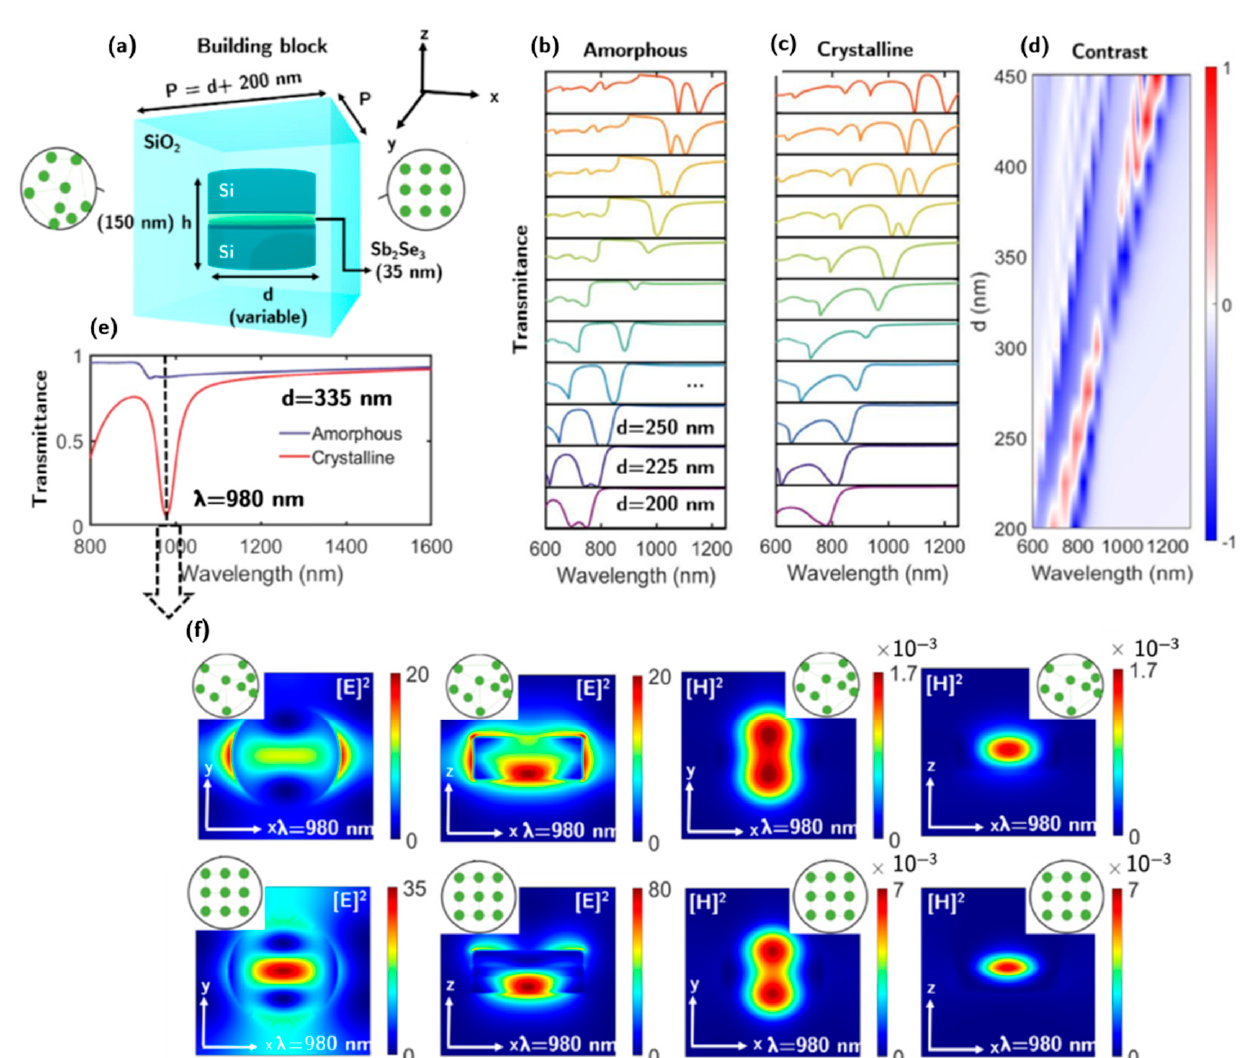
Figure 4. ( a ) The building block of the proposed reconfigurable metasurface. It consists of a sandwich-shaped Si–Sb 2 Se 3 –Si disk embedded in a SiO 2 medium. ( b , c ) Transmittance spectra of the metasurface for the Sb 2 Se 3 amorphous and crystalline phases, respectively, for disk diameters ranging from 200 to 450 nm. ( d ) Contrast in transmission ( ∆ T) between the crystalline and amorphous phases. ( e ) Transmission spectra for amorphous and crystalline phases for a diameter of 335 nm (i.e., an aspect ratio of h/d = 0.45). The dashed line at 980 nm indicates the transition between the zero-backward (amorphous) and the resonance due to the contributions of ED, MD, and AP (crystalline). ( f ) Square modulus of electric and magnetic fields in the near-field regime for different planes and both Sb 2 Se 3 phases at λ = 980